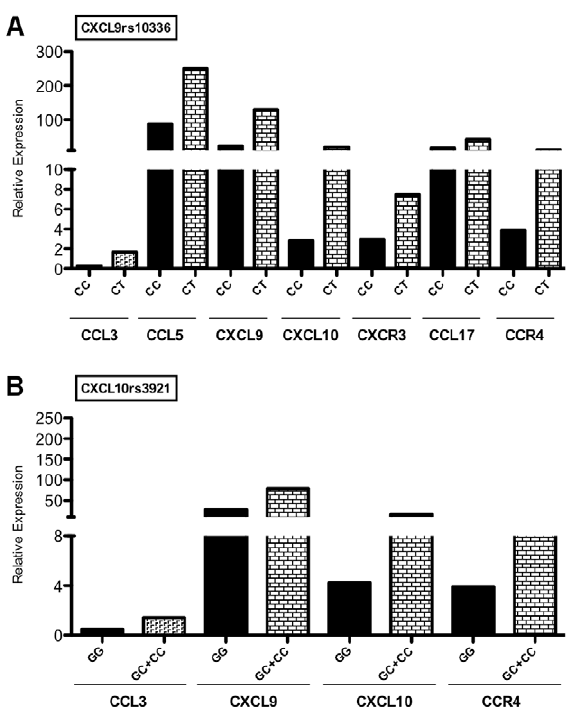
Figure 4. Chemokine and chemokine receptor expression in myocardium from patients bearing the CXCL9 and CXCL10 SNPs. Expression of chemokines and chemokine receptors in myocardium samples from patients bearing the CXCL9 rs10336 SNP (A). Expression of chemokines and chemokine receptors in myocardium samples from patients bearing CXCL10 rs3921 SNP (B). Real-time qPCR analysis of mRNA levels expression in myocardium samples from patients bearing the CXCL9 rs10336 CC (n=5) or CT (n=9) genotypes (A) and CXCL10 rs3921 GG (n=5) or CC or CG (n=9). The bar stands for the median.